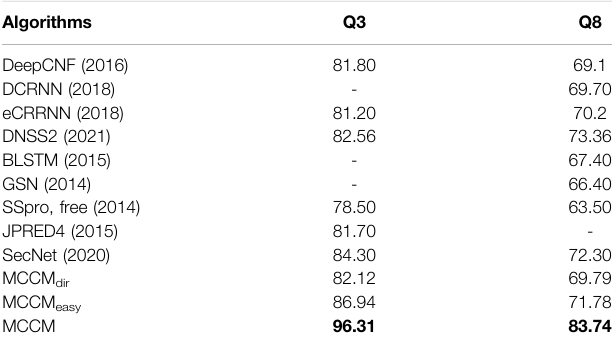
TABLE 2 | Q3 and Q8 accuracy of variant models on the public CB513 dataset.